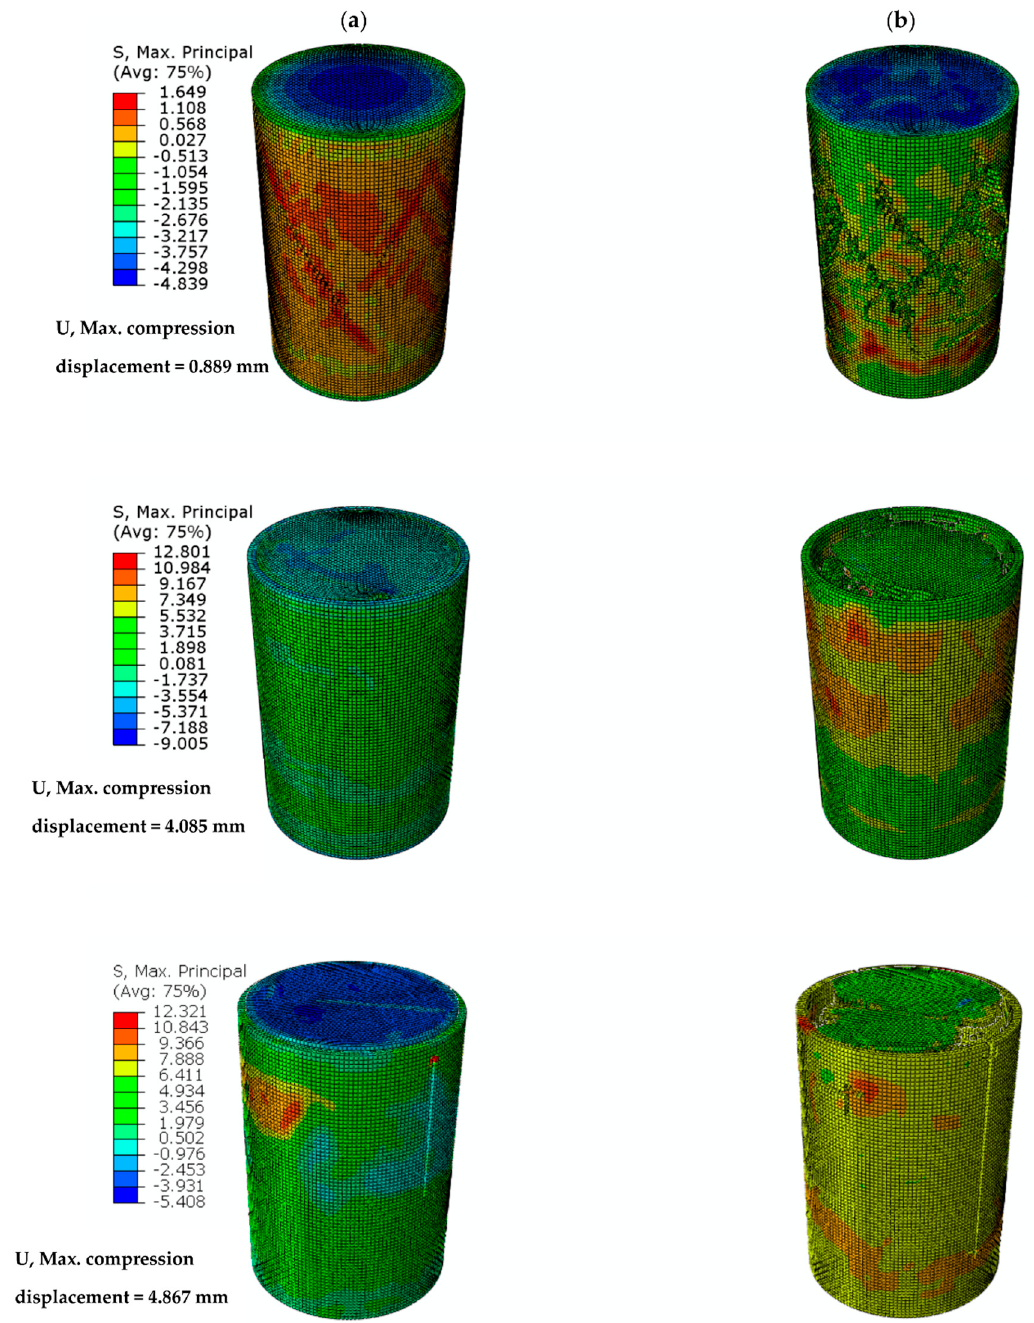
Figure 20. The failure mode of 250 mm samples with max principle stress. ( a ) before failure ( b ) after failure.